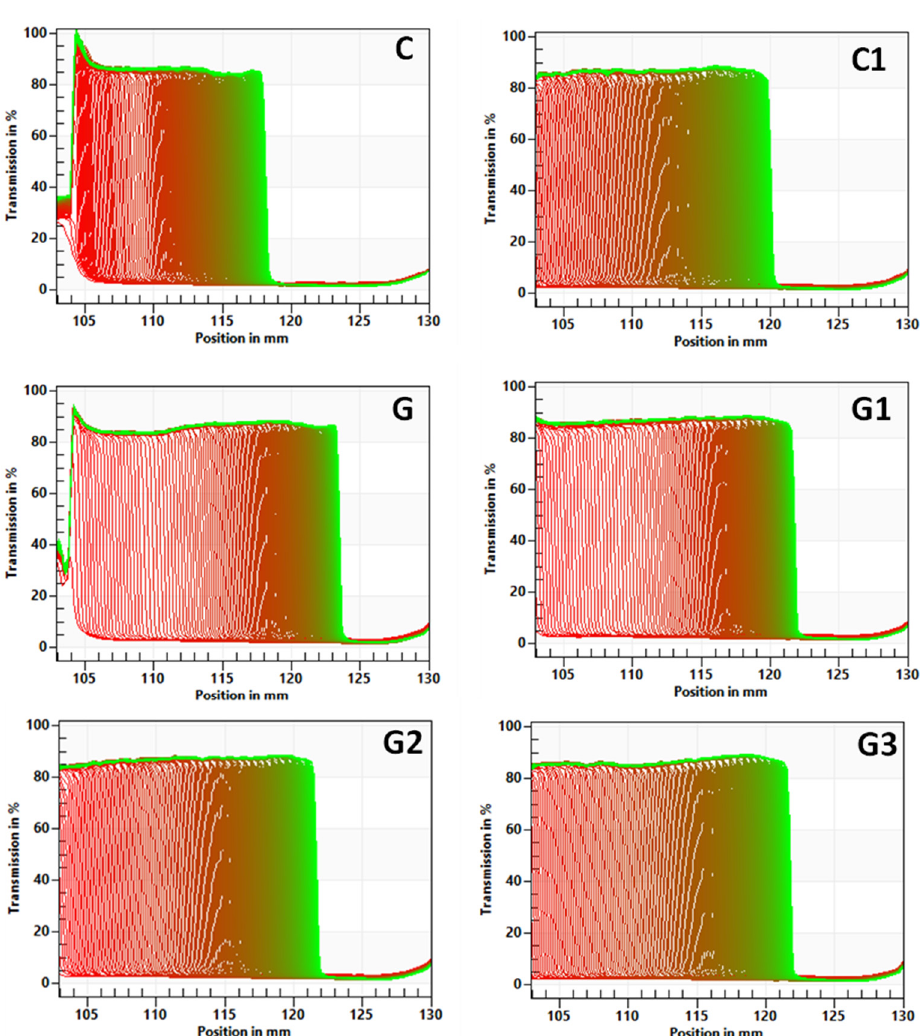
of the samples. Generally, the inulin addition did not improve the lightness of the yoghurts. The control yoghurt C and control yoghurt with inulin C1 were also not significantly differ. Table 2. Influence of the green tea addition on color parameters and the total color difference pa- The significant difference was also noticed for evaluation a* color parameters. All rameter of yoghurts. The abbreviations in the table refer to the control sample (C), control yoghurt tested green tea-infused yoghurts were characterized by significantly higher a* parameter, with 6% inulin (C1), yoghurt with green tea (G), yoghurt with green tea and 3% inulin (G1), yoghurt what is more the a* values of green tea yoghurts were positive what indicates that their color with green tea and 6% inulin (G2), yoghurt with green tea and 9% inulin (G3). changed towards red color. The addition of inulin did not influence this parameter. Similar Color Parameters Instability observations were made for the b* parameter. Significantly higher values of b* parameter Sample Index L* was obtained for samples with green tea addition ( b* for C—9.52, and for G—15.69) whereas the inulin addition did not influence this parameter. There were no differences between samples C and C1, but also there were no differences between yoghurt with green tea addition and different concentration of inulin (3–9%). 0.725 c ± 0.030 Values are mean ± SD ( n = 3), a, b, c—values followed by the same letter within a column do not differ significantly according to Tukey’s test ( p < 0.05).